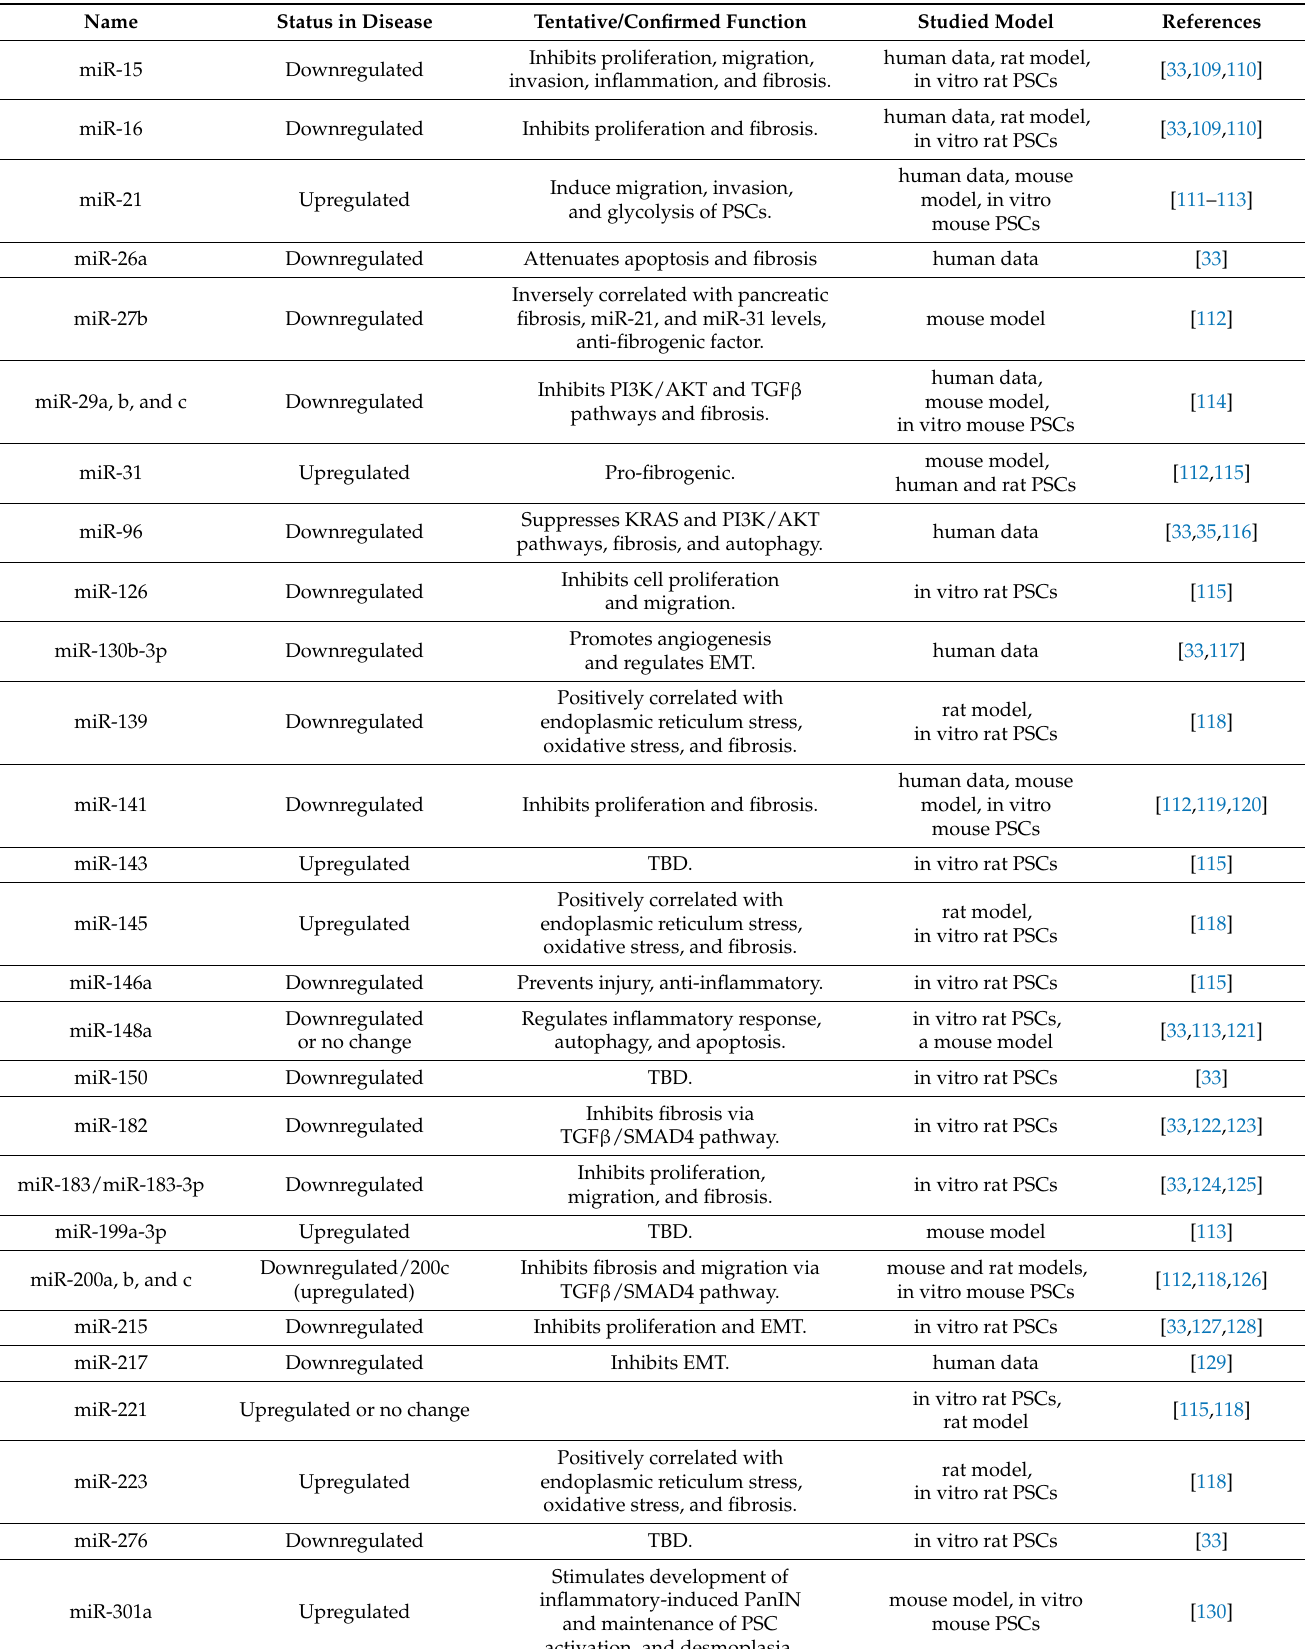
Table 3. Table summarizing the role of miRs in chronic